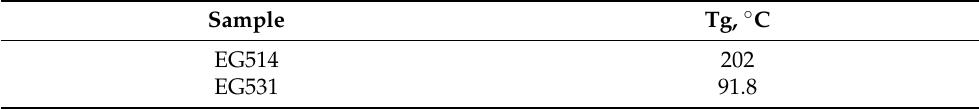
Table 3. T g of cured samples due to the DMA